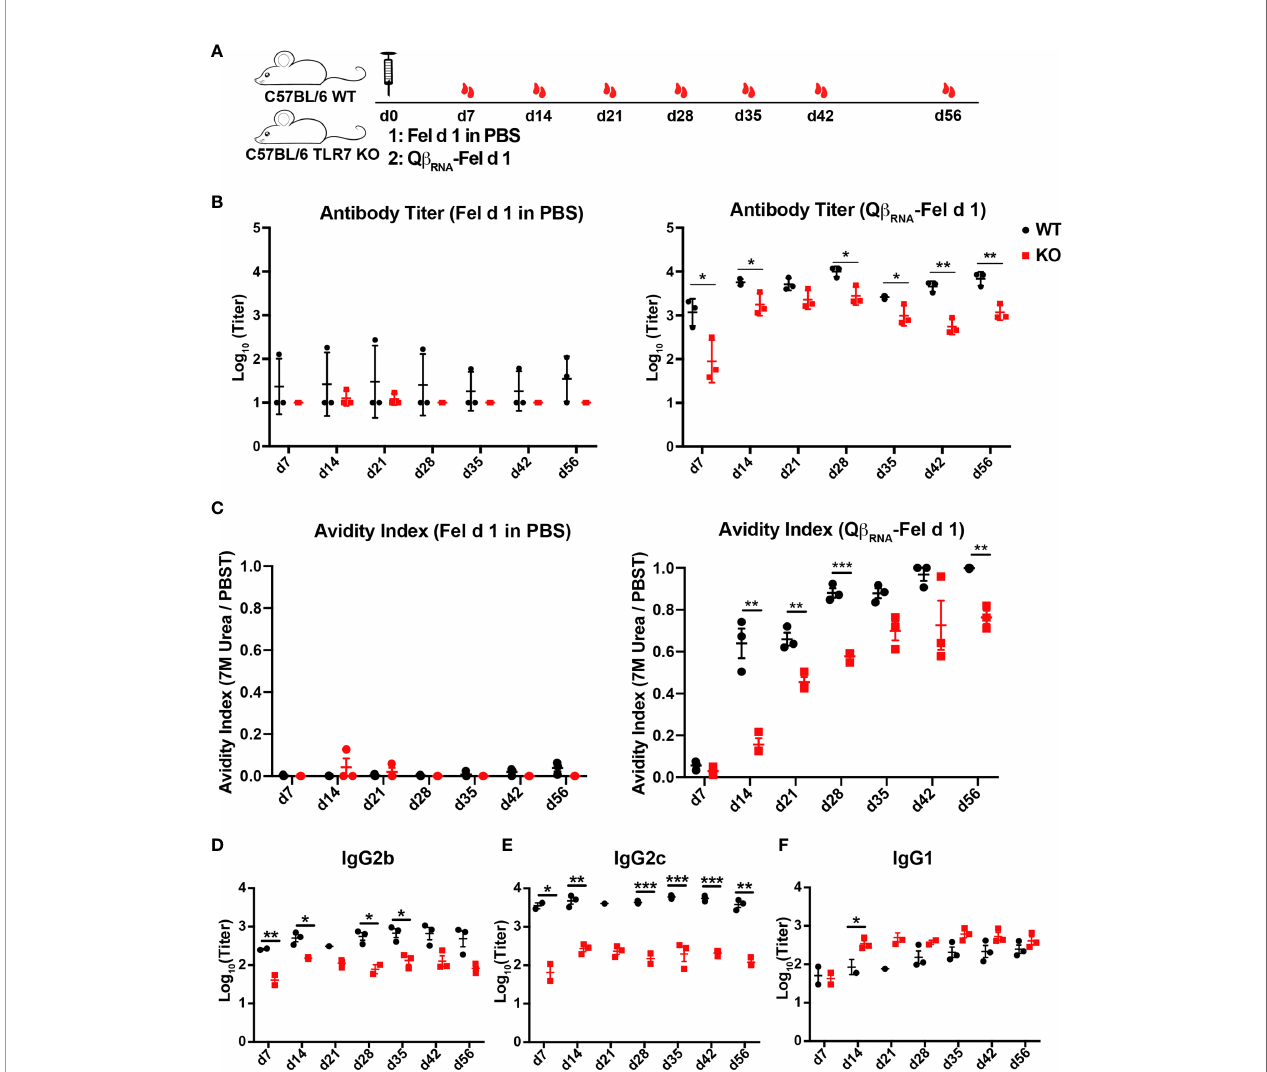
FIGURE 2 | Fel d 1-speci fi c antibody responses of WT and TLR7 KO mice upon Q b RNA -Fel d 1 immunization. (A) Immunization scheme. three mice per group were injected with 30 m g Q b RNA -Fel d 1 or Fel d 1 in PBS at d0, and mice were bled at d7, 14, 21, 28, 35, 42 and 56. Fel d 1-speci fi c antibody titers (B) and avidity indexes (C) in WT and TRL7 KO mice after immunization were demonstrated. IgG subclasses 2b (D) , 2c (E) and 1 (F) in WT and TRL7 KO mice after Q b RNA -Fel d 1 immunization were determined by ELISA. p value from unpaired t-test was indicated as ≤ 0.05 (*), ≤ 0.01 (**), ≤ 0.001 (***). The fi gure is representative of two independent